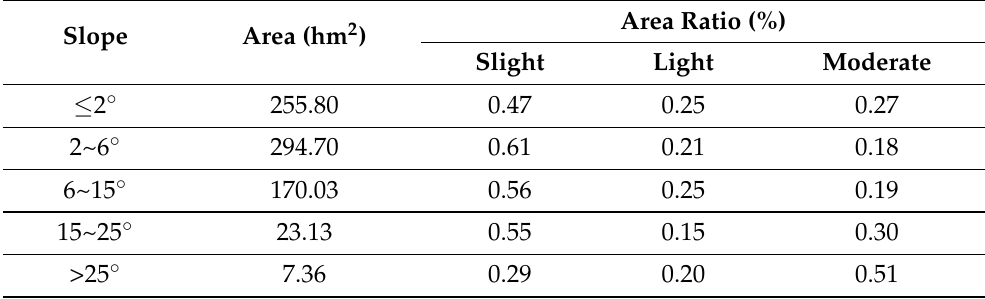
Table 6. Soil erosion intensity at different